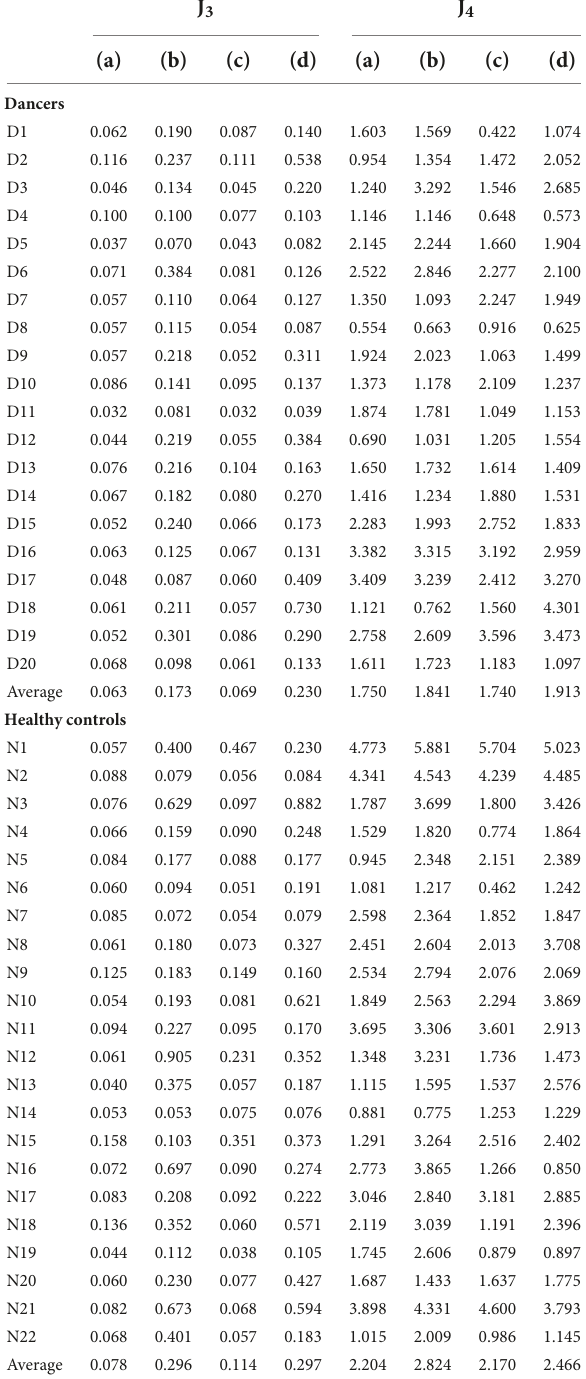
TABLE 4 The performance indexes J 3 and J 4 of the subjects during the one-leg stance